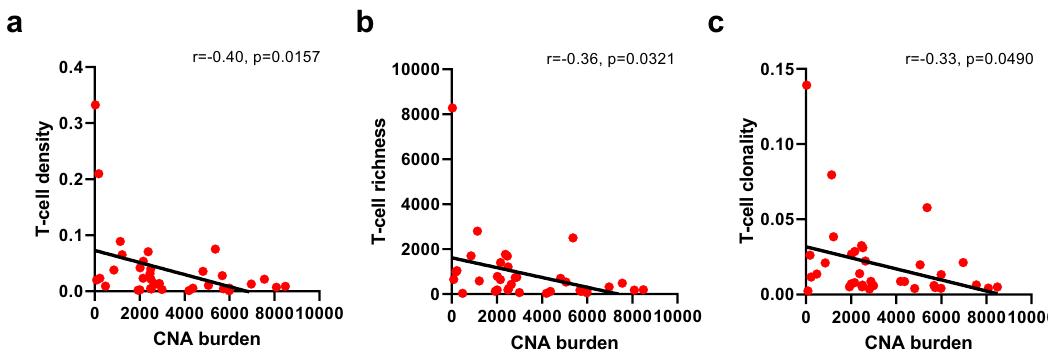
Fig. 5 Associations of chromosomal copy number aberrations (CNAs) with T cell receptor (TCR) repertoire. CNA burden and its negative correlations with T-cell ( a ) density, ( b ) richness, and ( c ) clonality in 36 small-cell lung cancer (SCLC) samples with both CNA and TCR data available. The correlation coef fi cient (r) was assessed by two-tailed Spearman ’ s rank-correlation test. Source data are provided as a Source Data fi le.